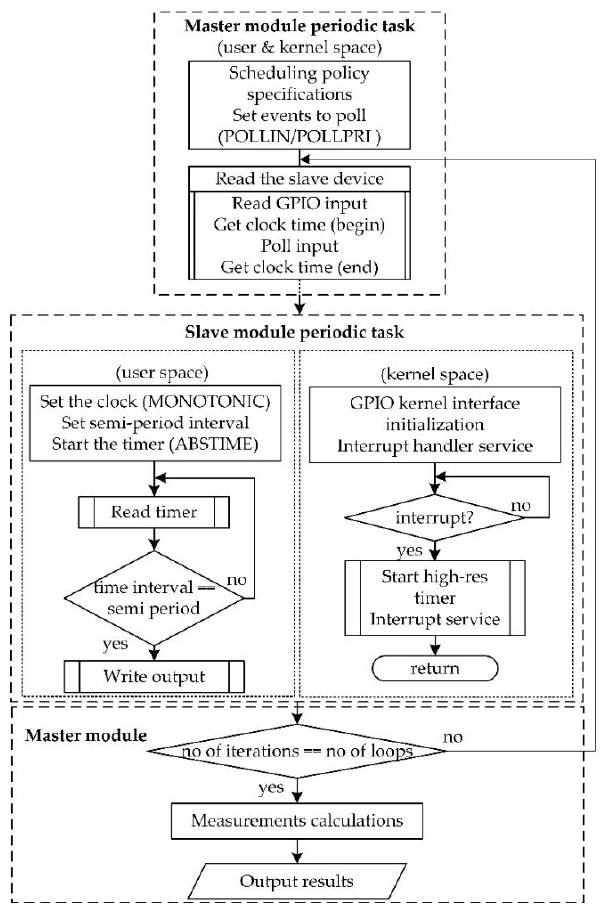
Figure 6. User and kernel space periodic task measurement algorithm.